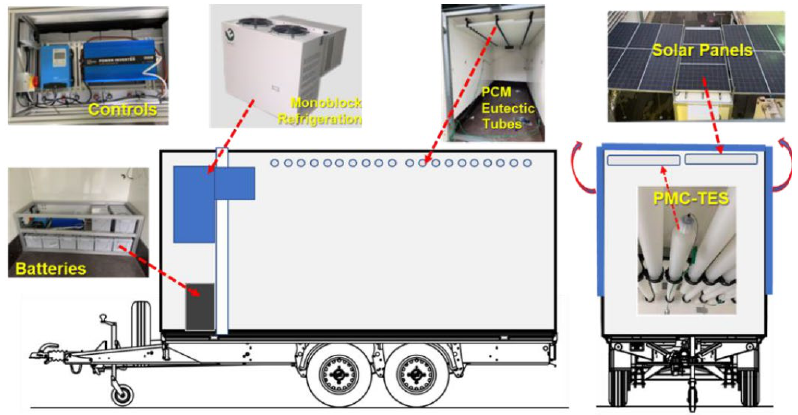
Figure 4. Mobile solar-driven freezer/pre-cooler (source: Phase Change Material Products Ltd.).